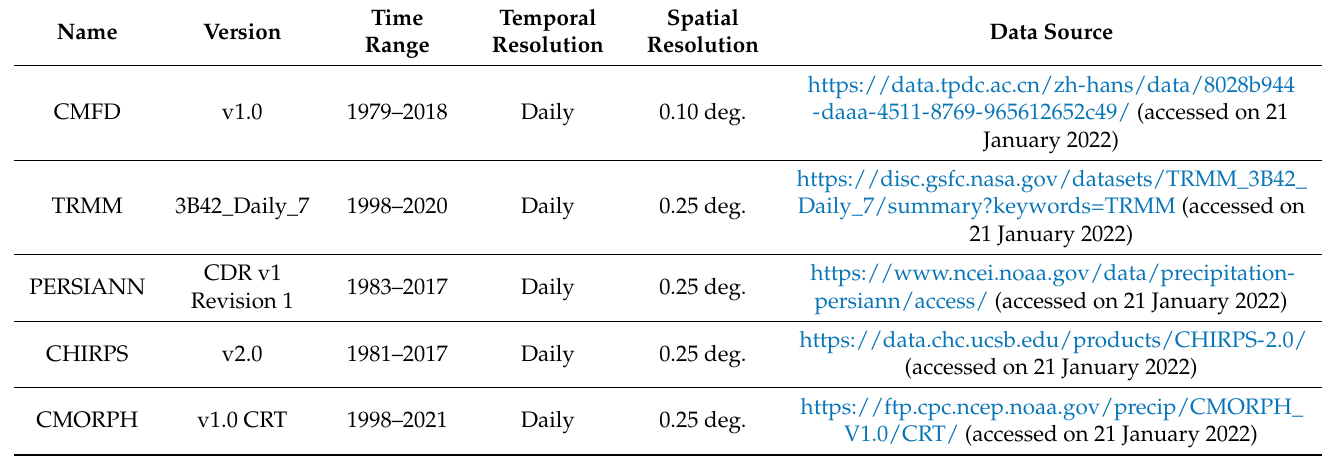
Table 1. Information about the observation data and satellite